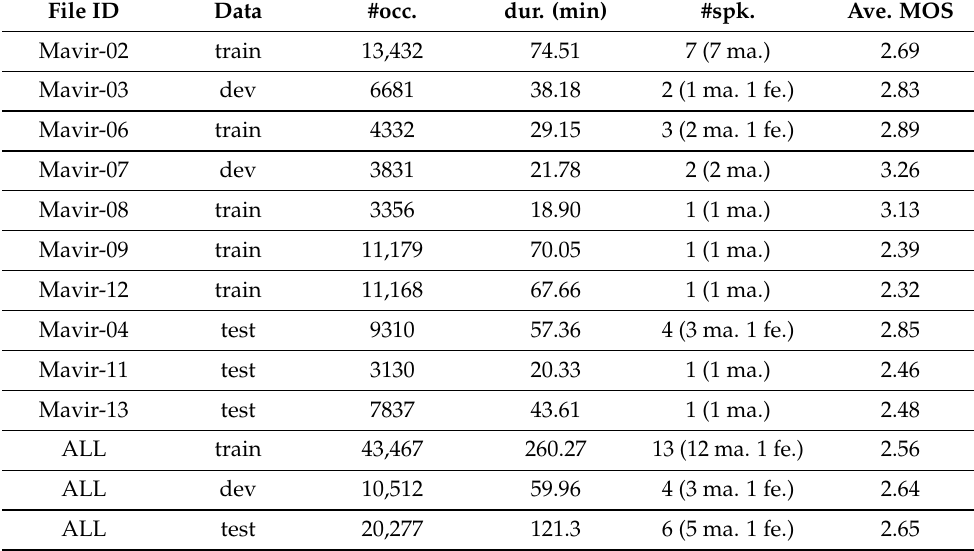
Table 1. Characteristics of the MAVIR database: number of word occurrences (#occ.), duration (dur.) in minutes (min), number of speakers (#spk.) and average MOS (Ave. MOS). These characteristics are displayed for training (train), development (dev) and testing (test) datasets.